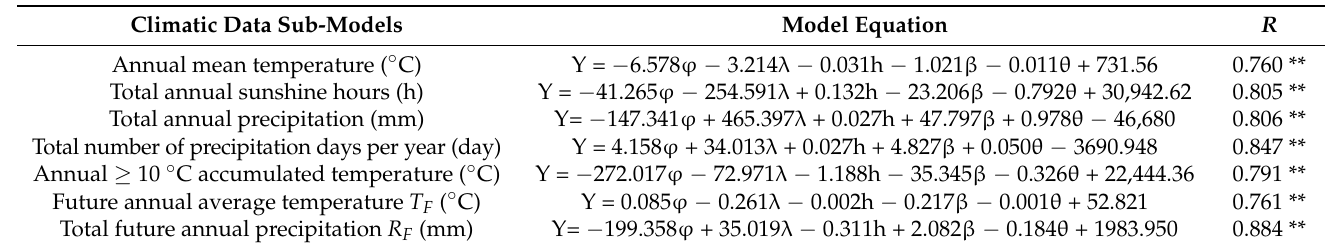
Table 3. Spatial analysis climatic suitability index model of green orange based on past and present climatic data sub-models and future climatic scenarios in Hainan